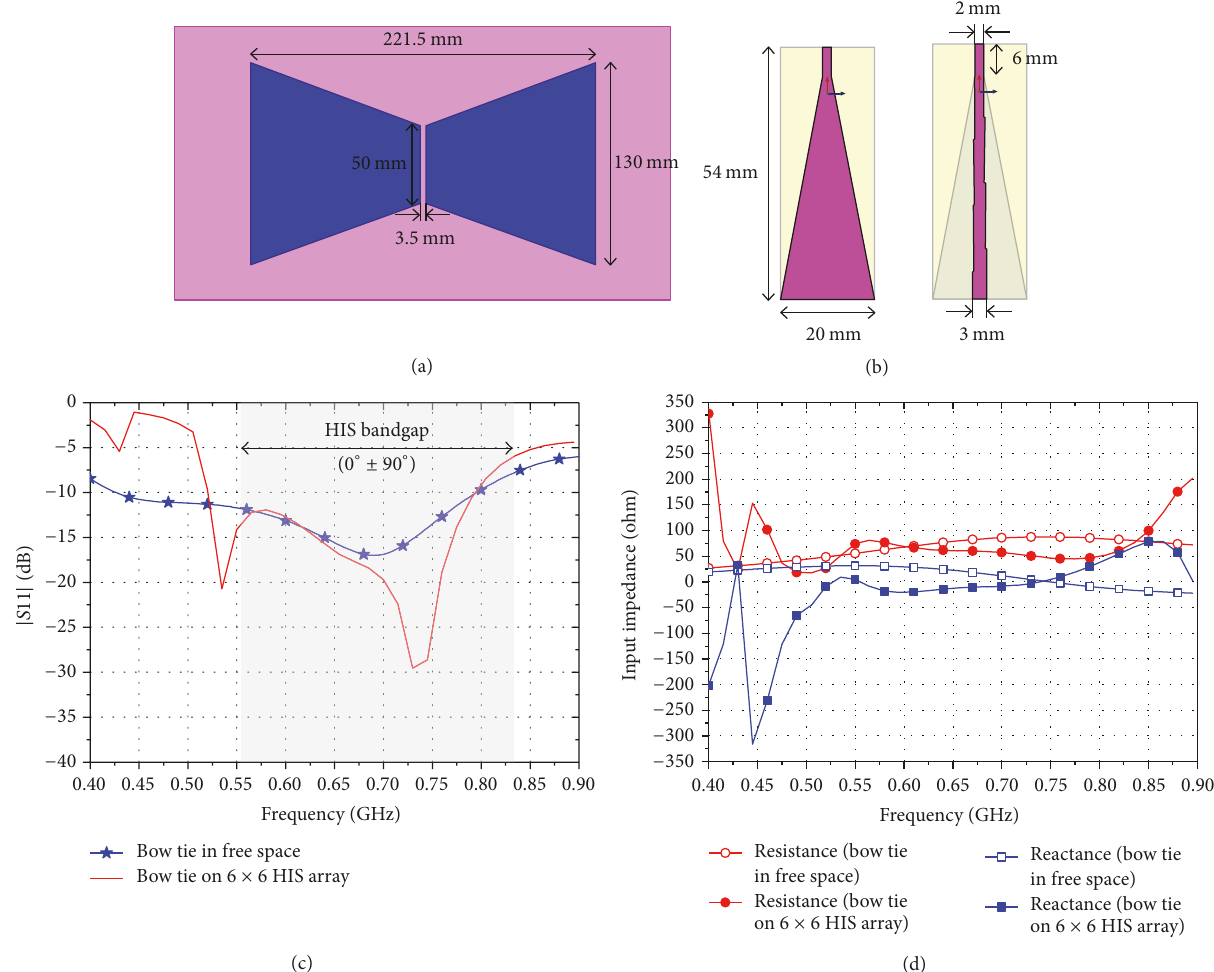
Figure 2: The bow tie antenna: (a) bow tie arms, (b) balun, (c) |𝑆 11 | curves, and (d) input impedance.